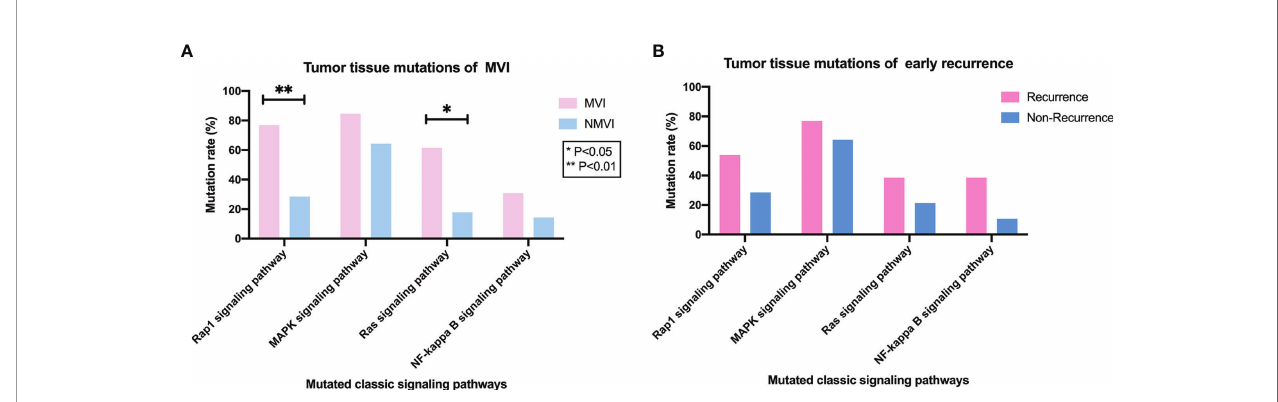
FIGURE 4 | Association between classic signaling pathways alterations in tumor tissues and MVI or early-recurrence status. (A) Comparison of mutation frequency of classic tumor pathways (i.e., Rap1, MAPK, Ras, and NF-kappa B signaling pathways) between MVI and NMVI patients. (B) Comparison of mutation frequency of Rap1, MAPK, Ras and NF-kappa B signaling pathways between early-recurrence and non-recurrence